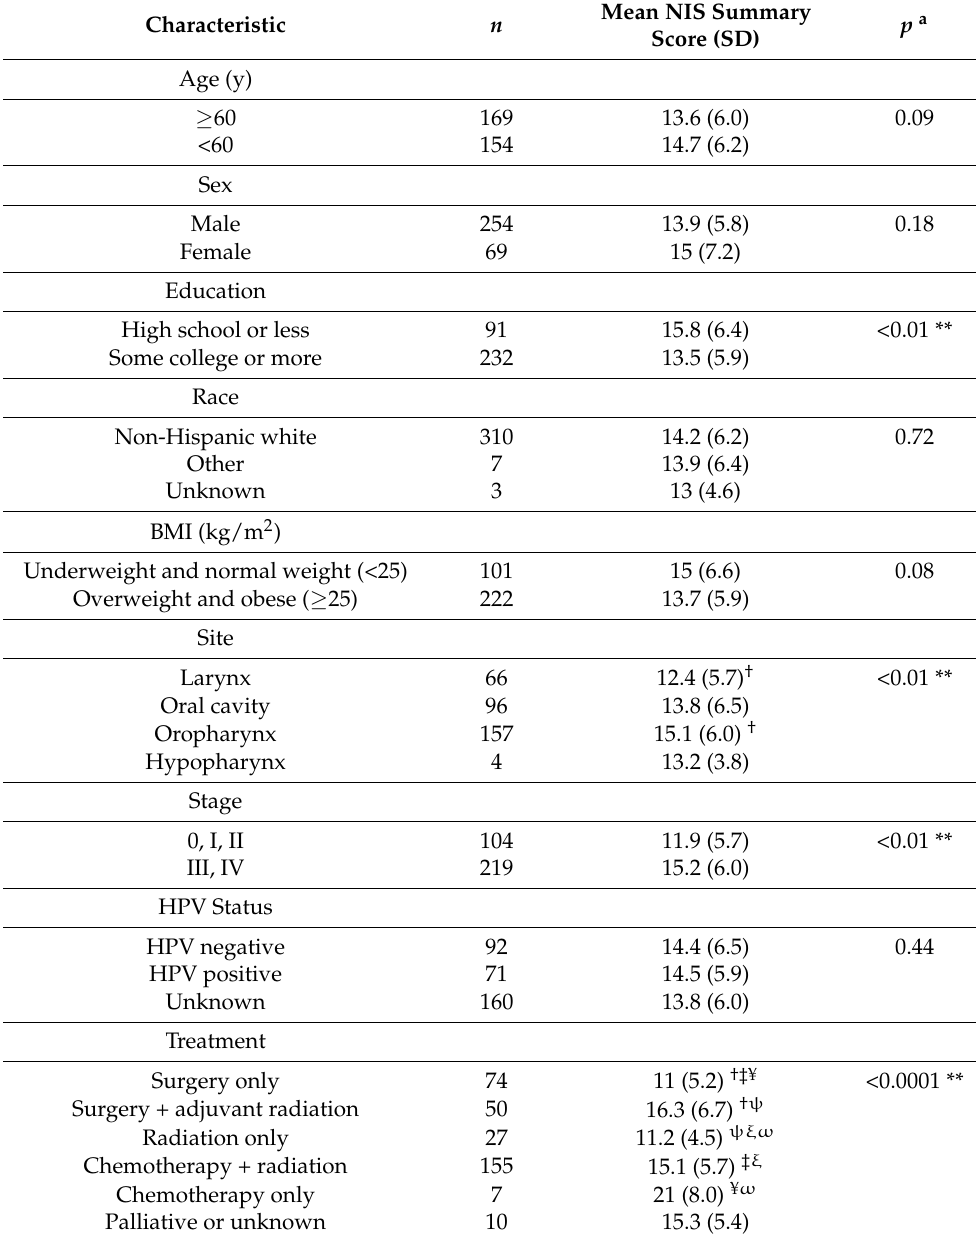
Table 2. Mean 1-year NIS summary score across select demographic, clinical, and behavioral charac- teristics ( n =